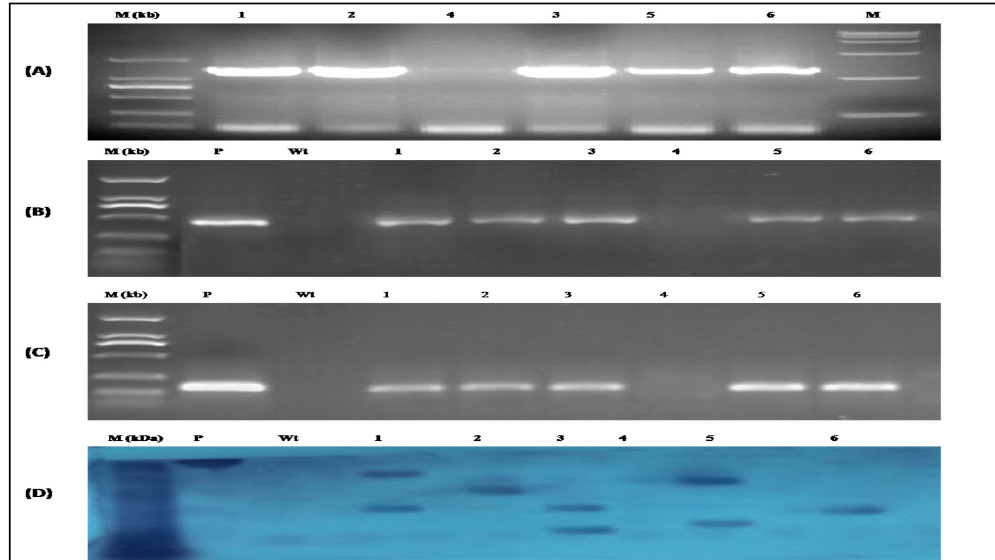
Figure 4. Detection of transgenic Arabidopsis lines harboring the pBASTA-CtCYP82G24 transgene.